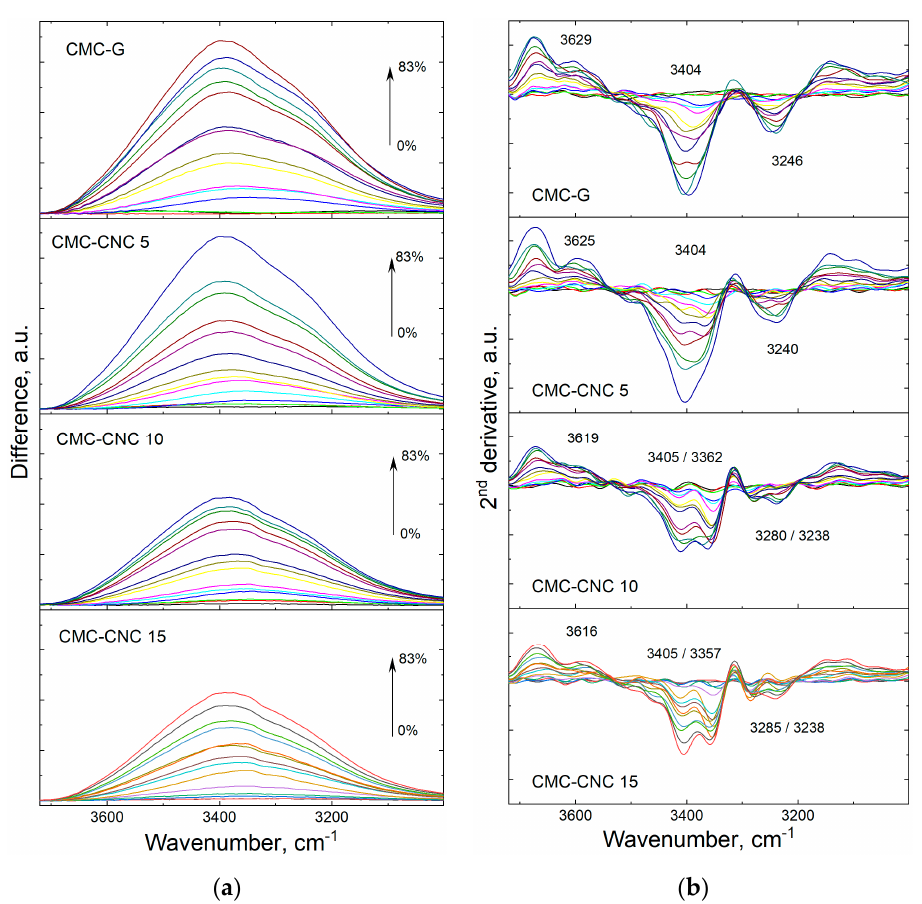
Figure 10. Difference infrared spectra ( a ) showing the increase of the integral area of the water band with the increase in MC content and their second derivatives ( b ).